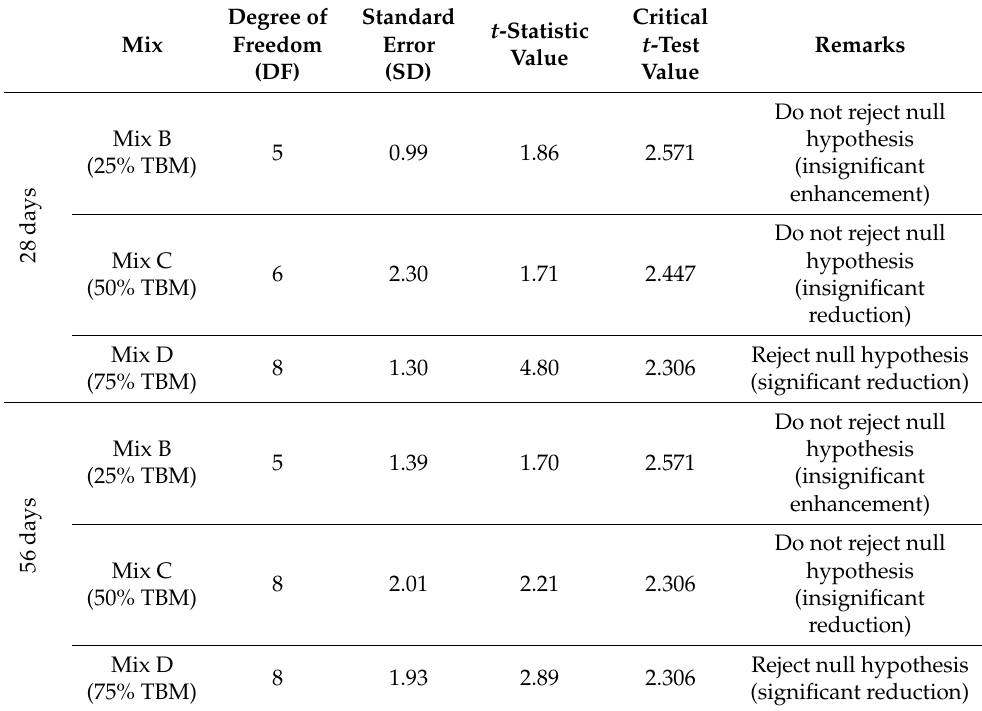
Table 5. Compressive strength t -statistical